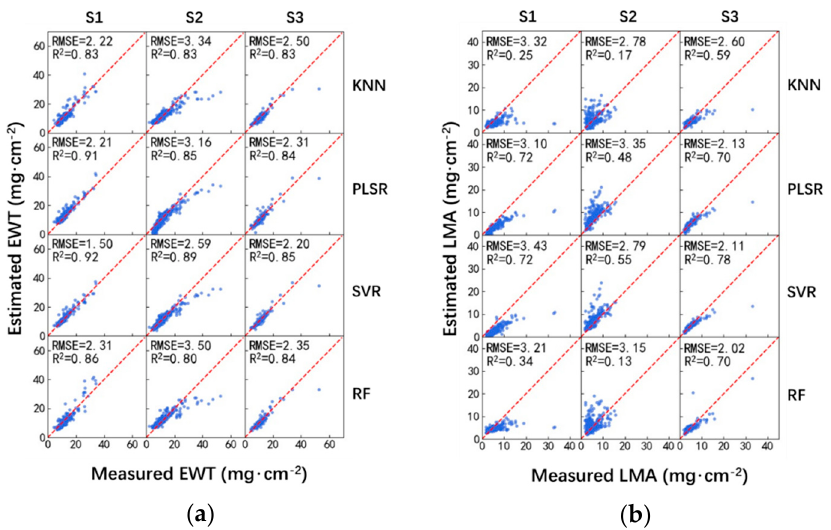
Figure 3. Performance of EWT ( a ) and LMA ( b ) estimation using ML-reflectance-based method.